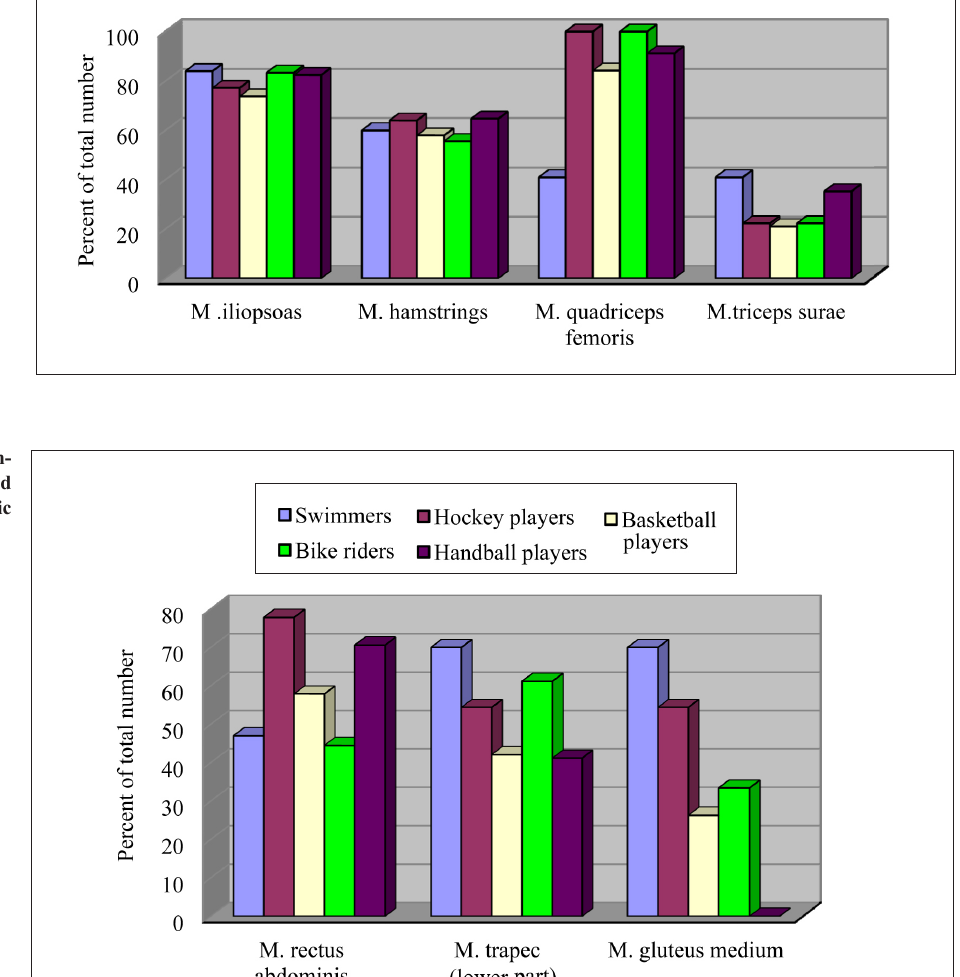
Figure 3. Results of swim- mer, ice-hockey, bike rider, handball player and basketball player